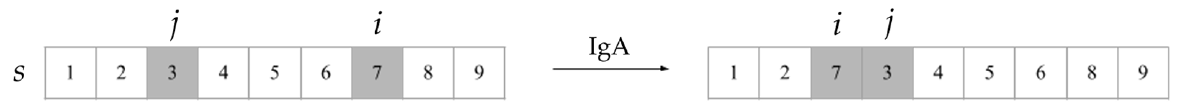
Figure 6. The operation of IgM mode. Figure 7. The operation of IgA mode.